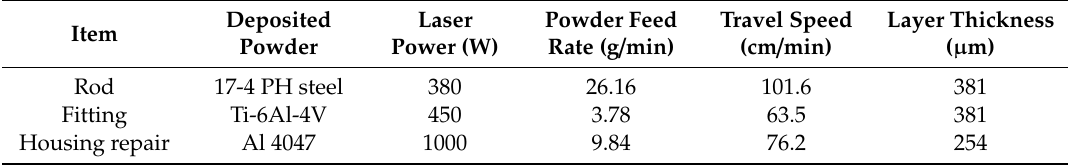
Table 1. Summary of LENS deposition